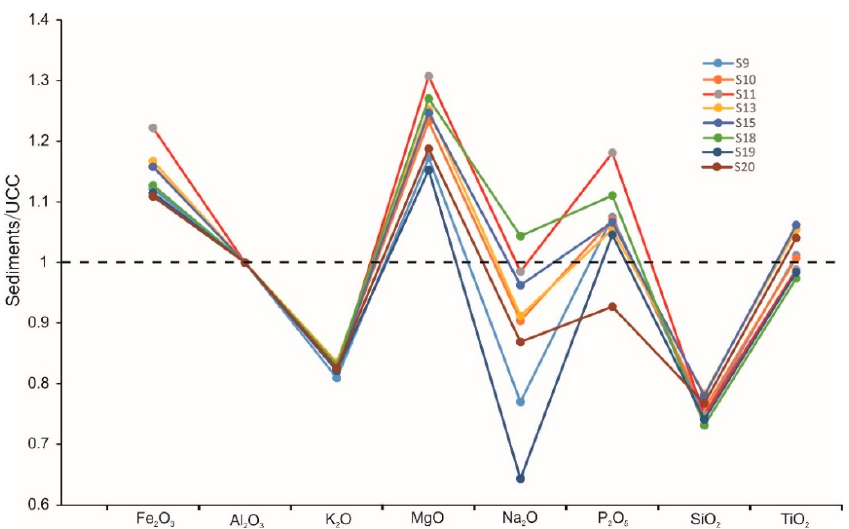
Figure 6. Elemental ratios of surface sediments in the Xisha Uplift normalized to the upper continental crust (UCC) (Taylor and McLennan, 1985) with respect to Al 2 O 3 .